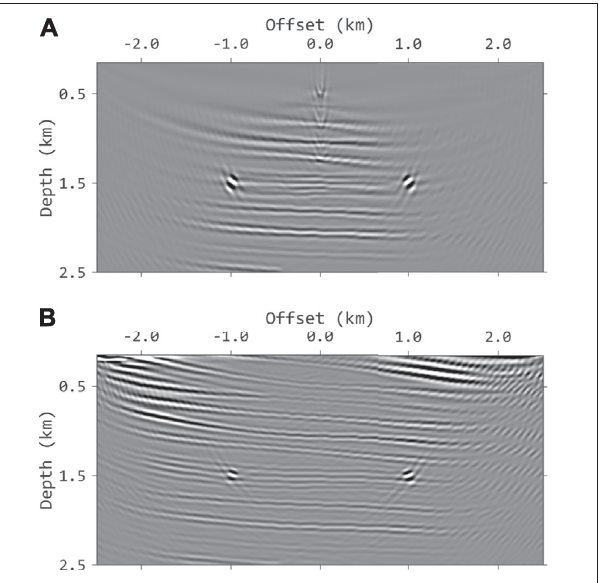
FIGURE 8 | The results using inverse-scattering imaging condition with wave fi eld decomposition. (A) The image using primaries only. (B) The image using DDM. Compared to Panel 7 , the resolution is well